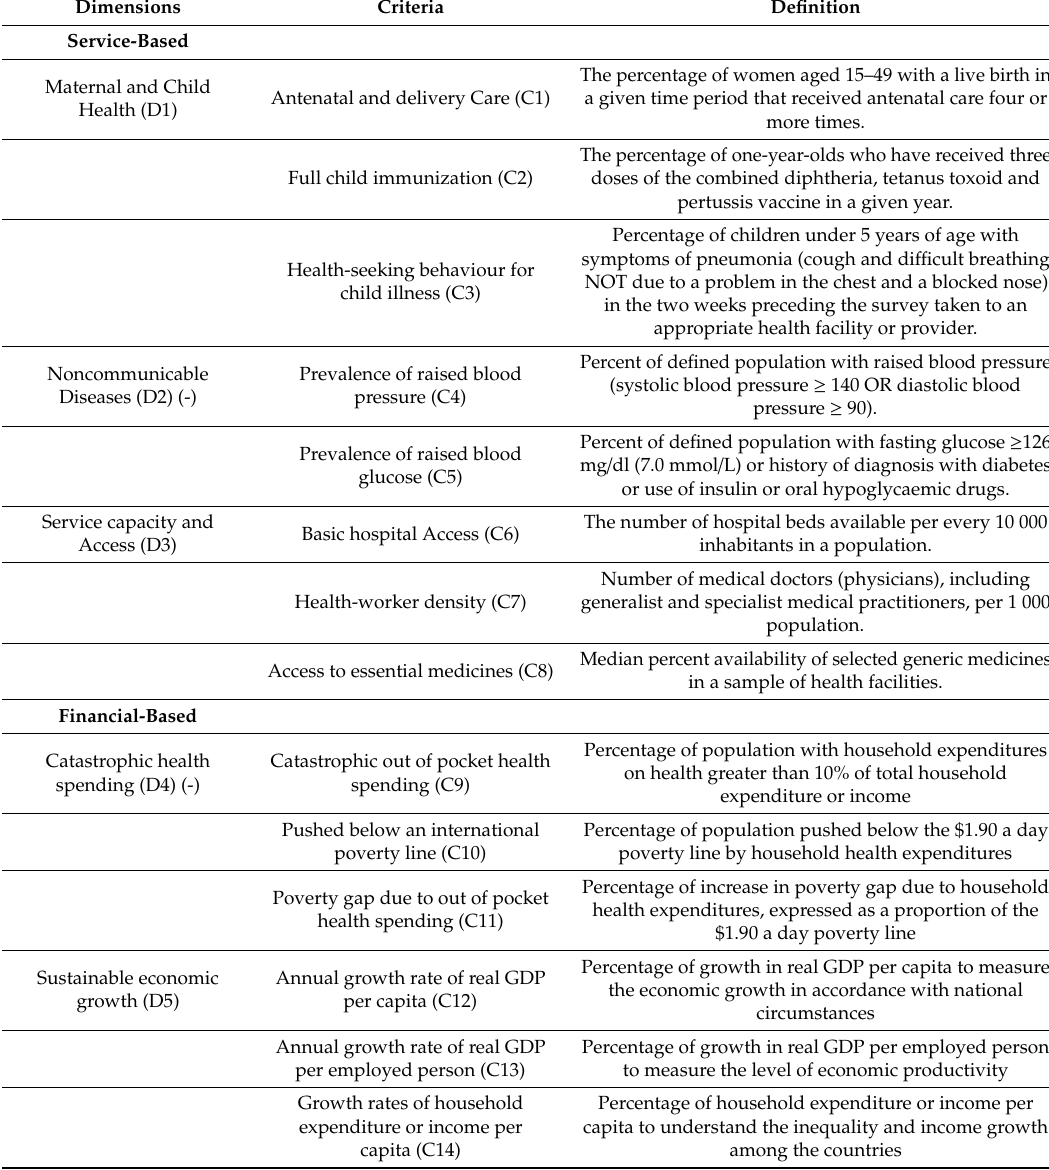
Table 1. Service and financial-based factors of universal health